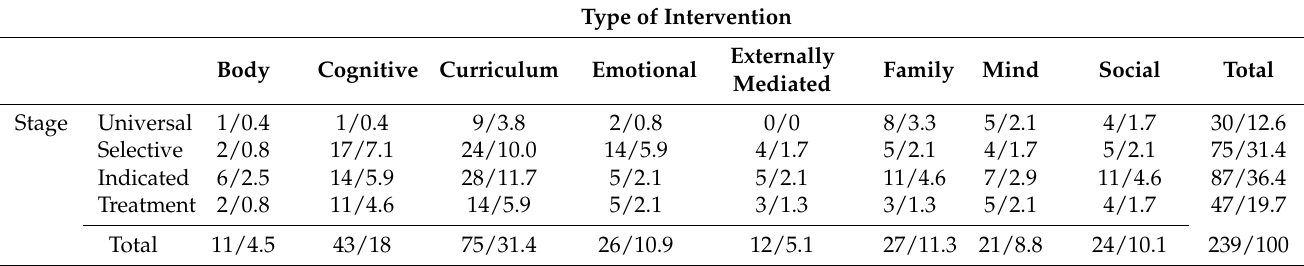
Table 2. Number/percentage of studies classified by the type of intervention and its stage.